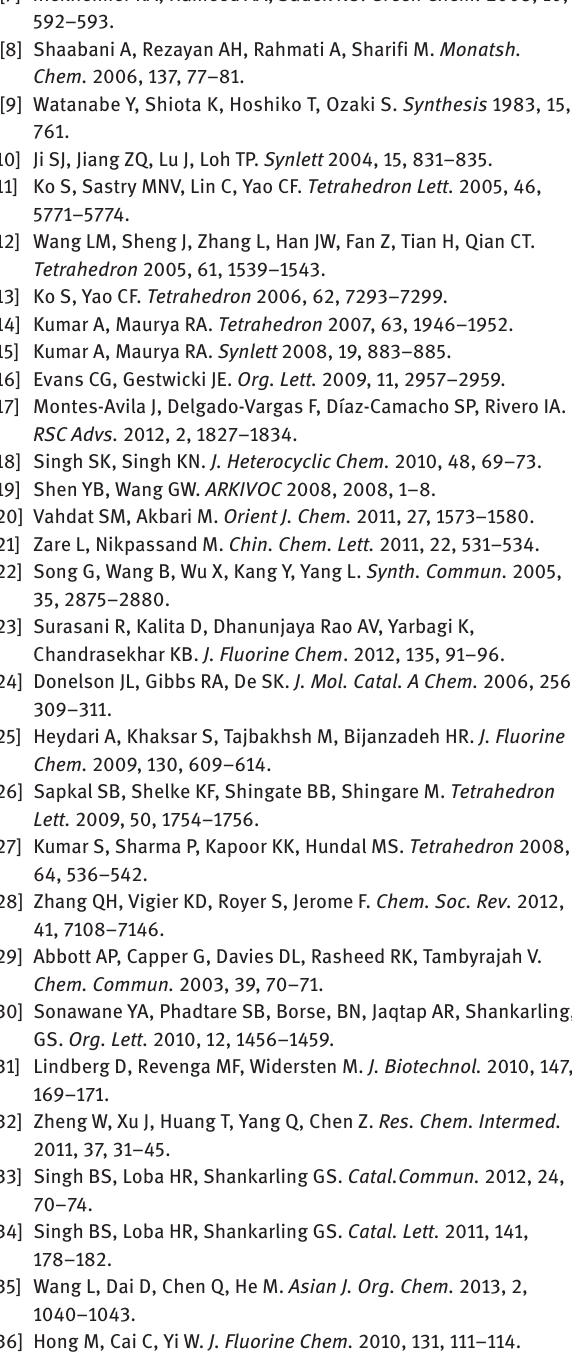
Table 3 Synthesis of PHQ derivatives in ChCl/urea.